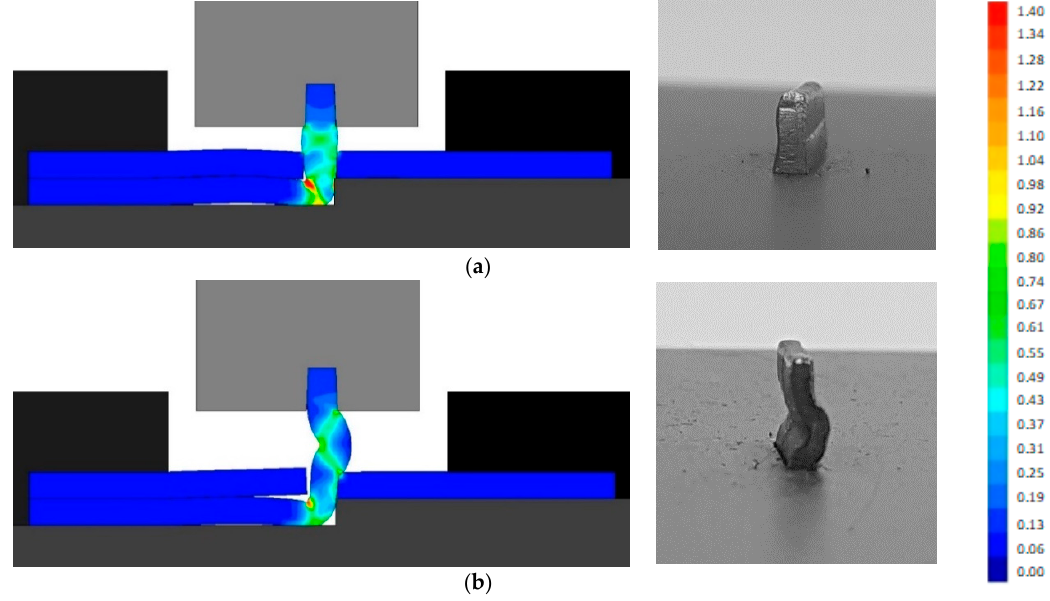
Figure 5. Assembling the individual formed panels of the thin-walled crash boxes: ( a ) effective strain distribution at the end of the first stage of the sheet-bulk compression of a tenon with a free length h = 4.5 mm; ( b ) effective strain distribution at the end of the first stage of the sheet-bulk compression of a tenon with a free length h = 6